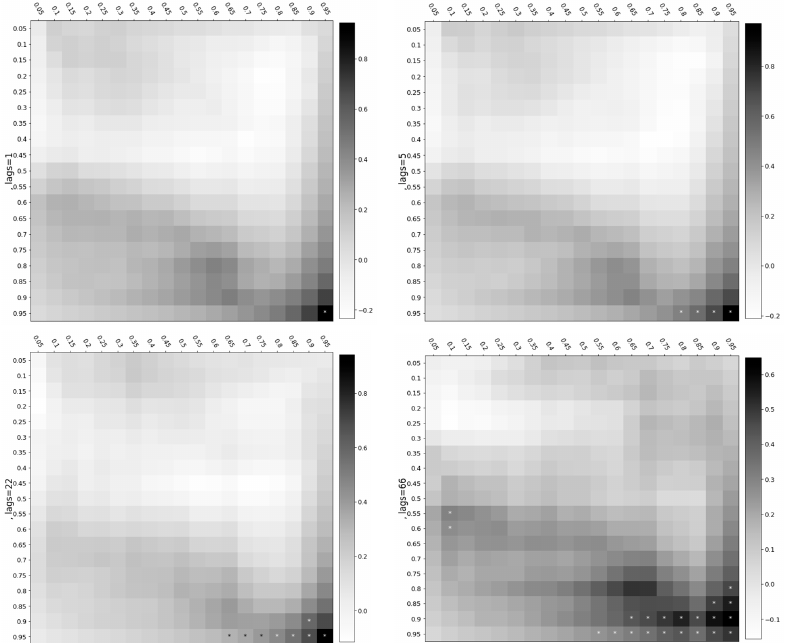
Figure 8. Cross-quantilogram dependence from Moderna to Pfizer. Notes: The vertical axis indicates the quantile distribution of Moderna’s stock return, whereas the horizontal axis indicates the quan- tile distribution of Pfizer’s stock return. The white-to-black intensity in the bar indicates negative to positive associations. Figure 9 shows the cross-quantile dependence from Moderna to AstraZeneca. This spillover becomes more profound when considering longer memories. In the short term (the 1-day and 5-day lags), Figure 9 demonstrates that Moderna under the middle and higher quantiles transmits volatility spillover to AstraZeneca under almost all quantiles. In the long term, a larger number of significant squares with a positive correlation is ob- served.